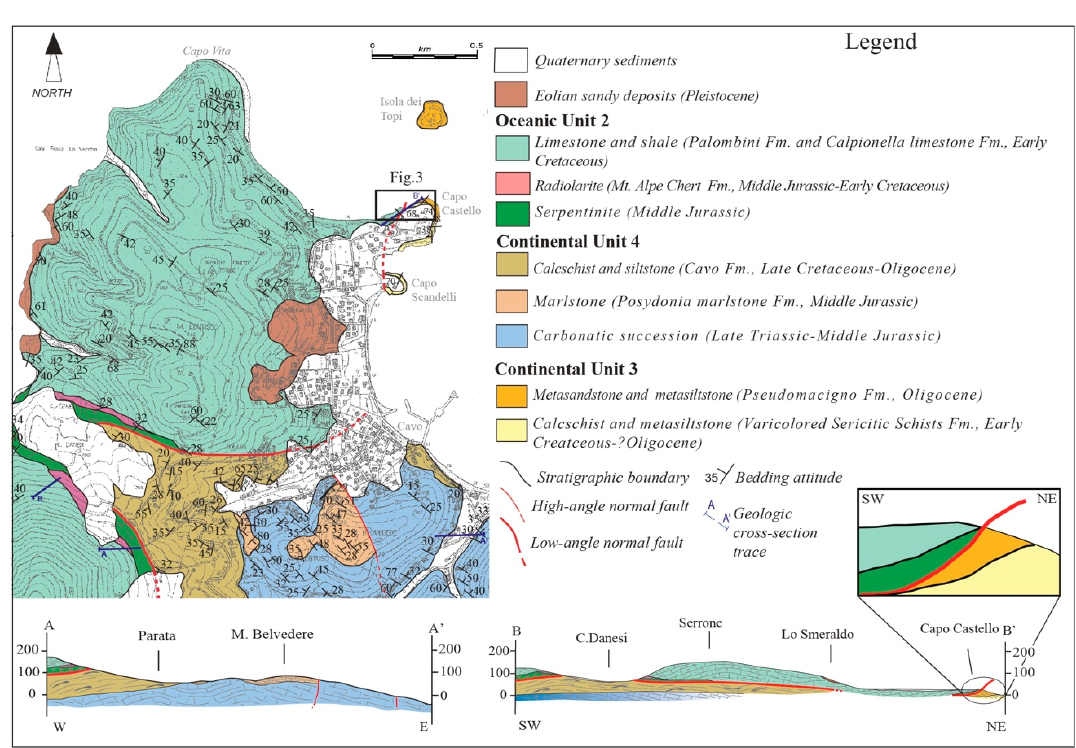
Figure 2. Geologic map and cross sections of the study area. The black square indicates the location Capo Castello shear zone. A schematic and not-to-scale cross section of the study shear zone (grey shade) is also showed, corresponding to the zoomed area within the BB’ cross section.